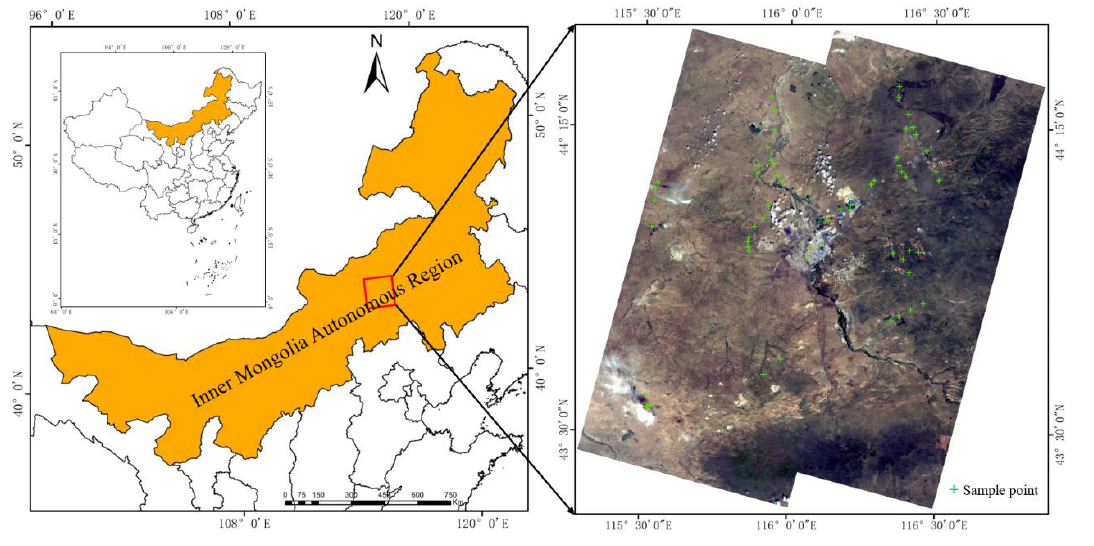
Figure 1. Location of the study area.